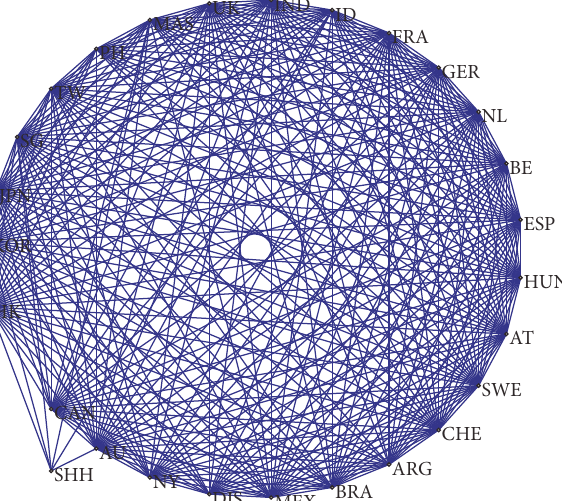
Figure 14: Topology graph of ISMN in